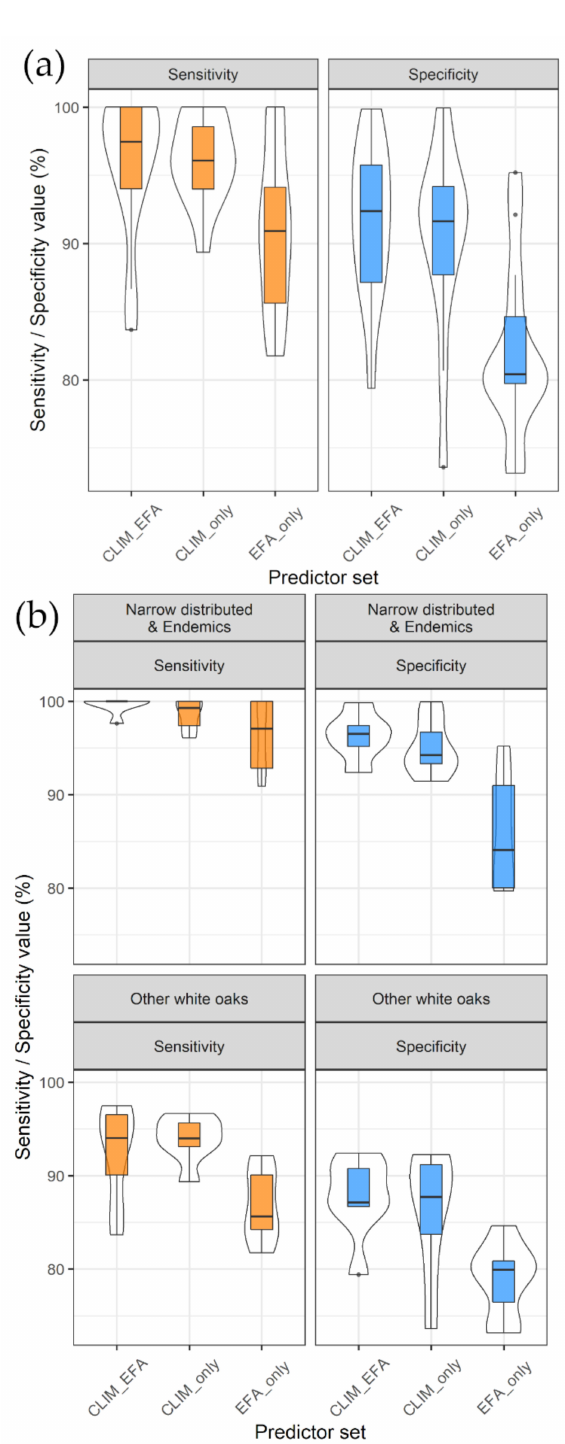
Figure 3. ( a ) Combined boxplot / violin plot with the comparison of sensitivity (or true positive rate) and specificity (or true negative rate) for all species between groups of variables. Boxes display (from bottom to top) the 25%, 50% (median) and 75% quartiles of the distribution; ( b ) the comparison of specificity values between di ff erent groups of species. Whiskers present the minimum and maximum values without outliers (shown as points). Sets of predictive variables (x axis) are: “CLIM_EFA” (climate and EFA combined), “CLIM_only” (climate variables only) and “EFA_only” (satellite EFA variables